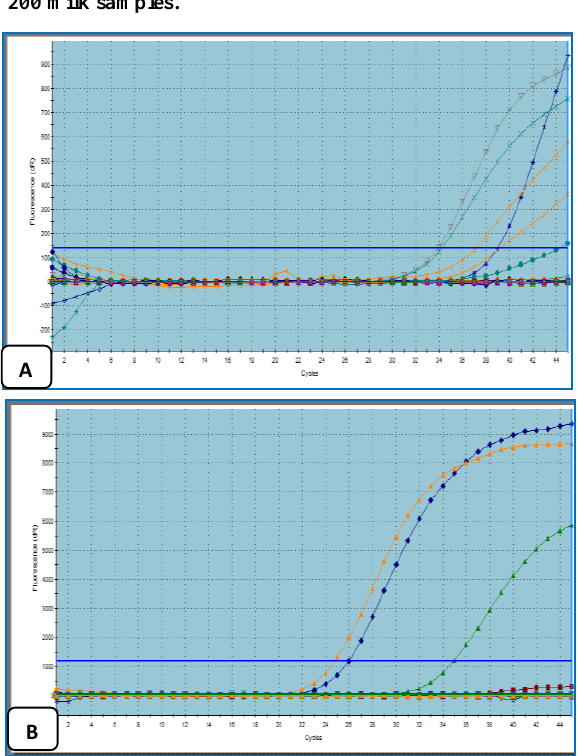
Figure, (2-A and B): shows positive Real time PCR amplification for M. capricolum for 200 DNA extract from 200 milk